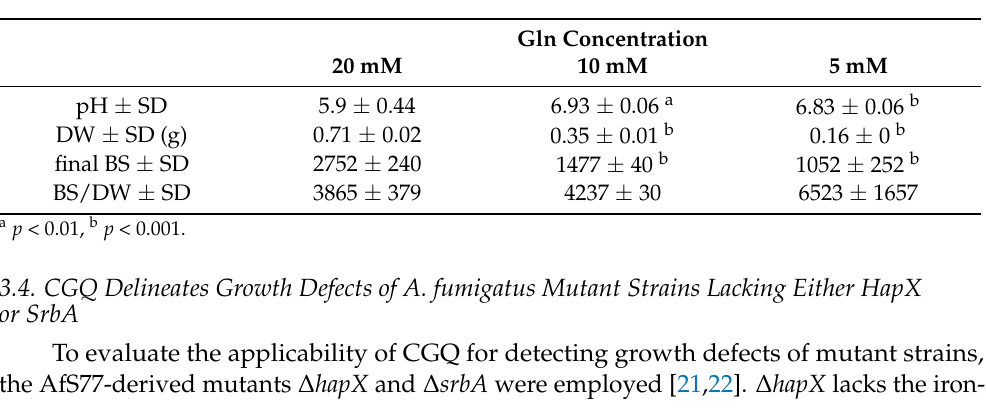
Figure 7. CGQ-mediated growth monitoring of A. fumigatus AfS77 cultured in biological triplicates for 22 h with 20 mM, 10 mM, or 5 mM glutamine (Gln). Details of the graph are as in the caption of Figure 2. Table 3. Comparison of DW, BS values, BS/DW ratios, and pH values of A. fumigatus AfS77 cultured in the presence of different glutamine (Gln) concentrations for 24 h. Mean ± standard deviation of biological triplicates is displayed. Statistically significant differences (marked by a or b ) of Gln limitation (5 mM and 10 mM) compared to the standard concentration (20 mM) were assessed by one-way ANOVA and Tukey’s multiple comparison